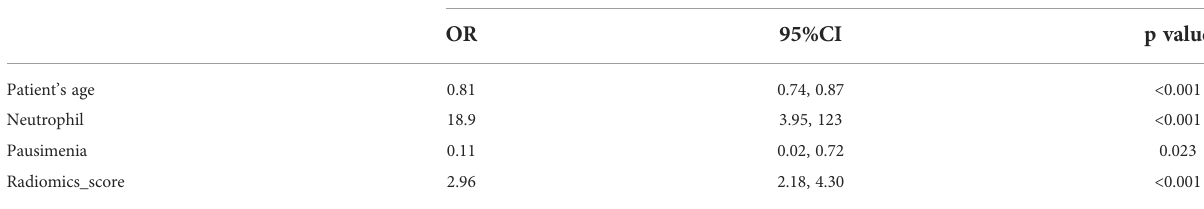
TABLE 4 Multivariate logistic regression